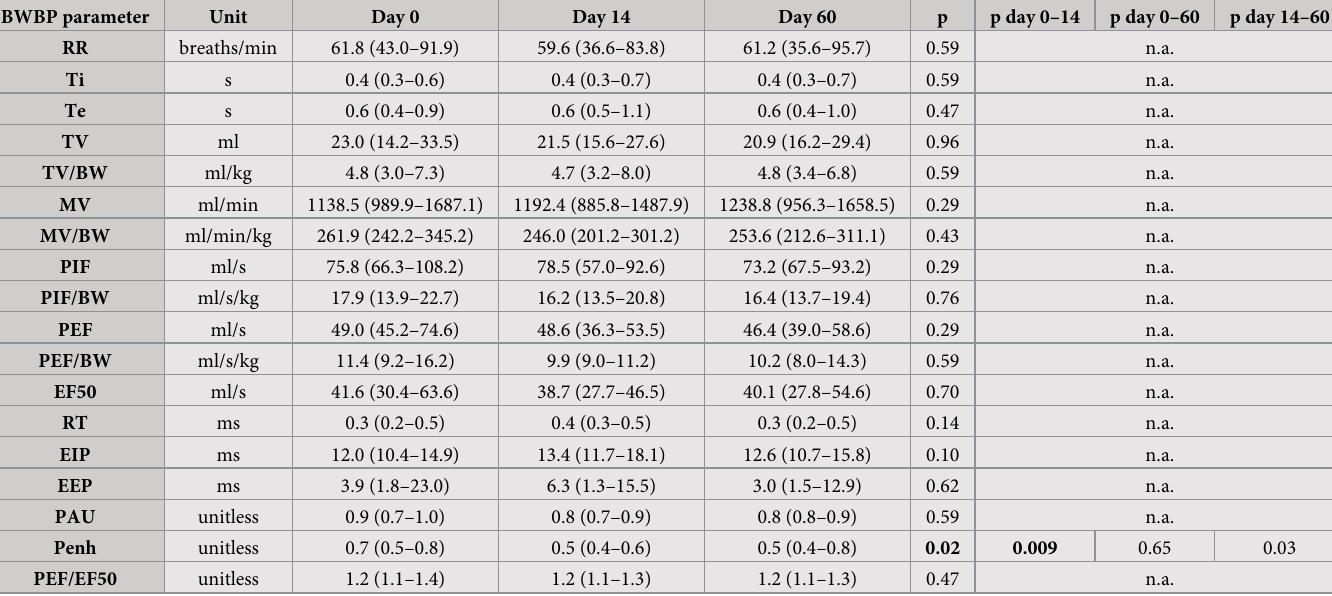
Table 5. BWBP parameters at all three examination time points in cats with FLAD. BWBP